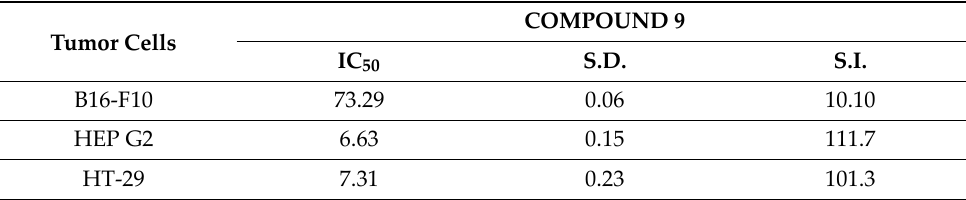
Table 3. Selectivity of compound 9